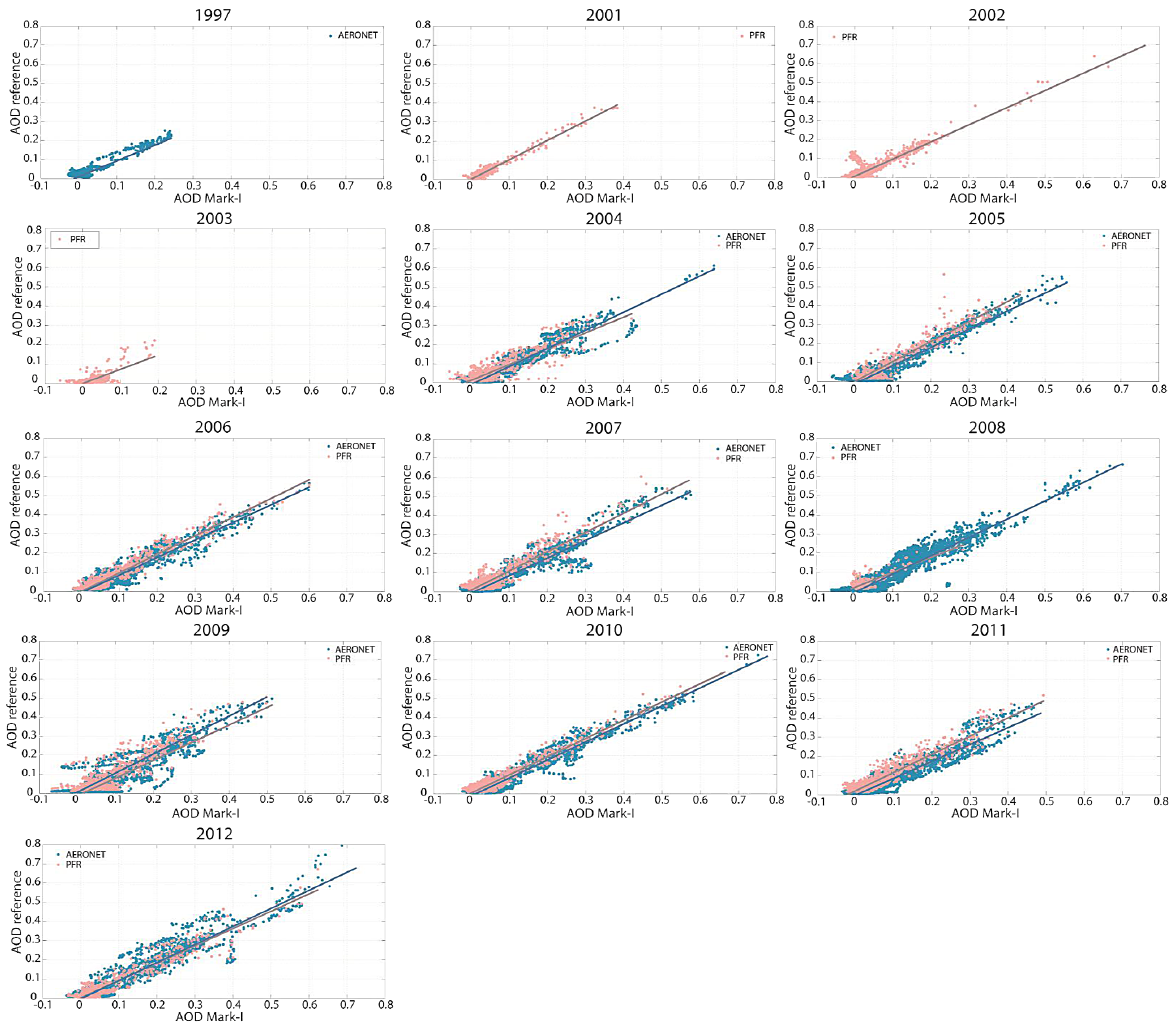
Figure 4. Scatter plots of daily AOD values from the Mark-I against the Cimel-AERONET (blue) and the PFR (pink) for each year (1997 and 2001–2012). Solid lines represent the linear regression